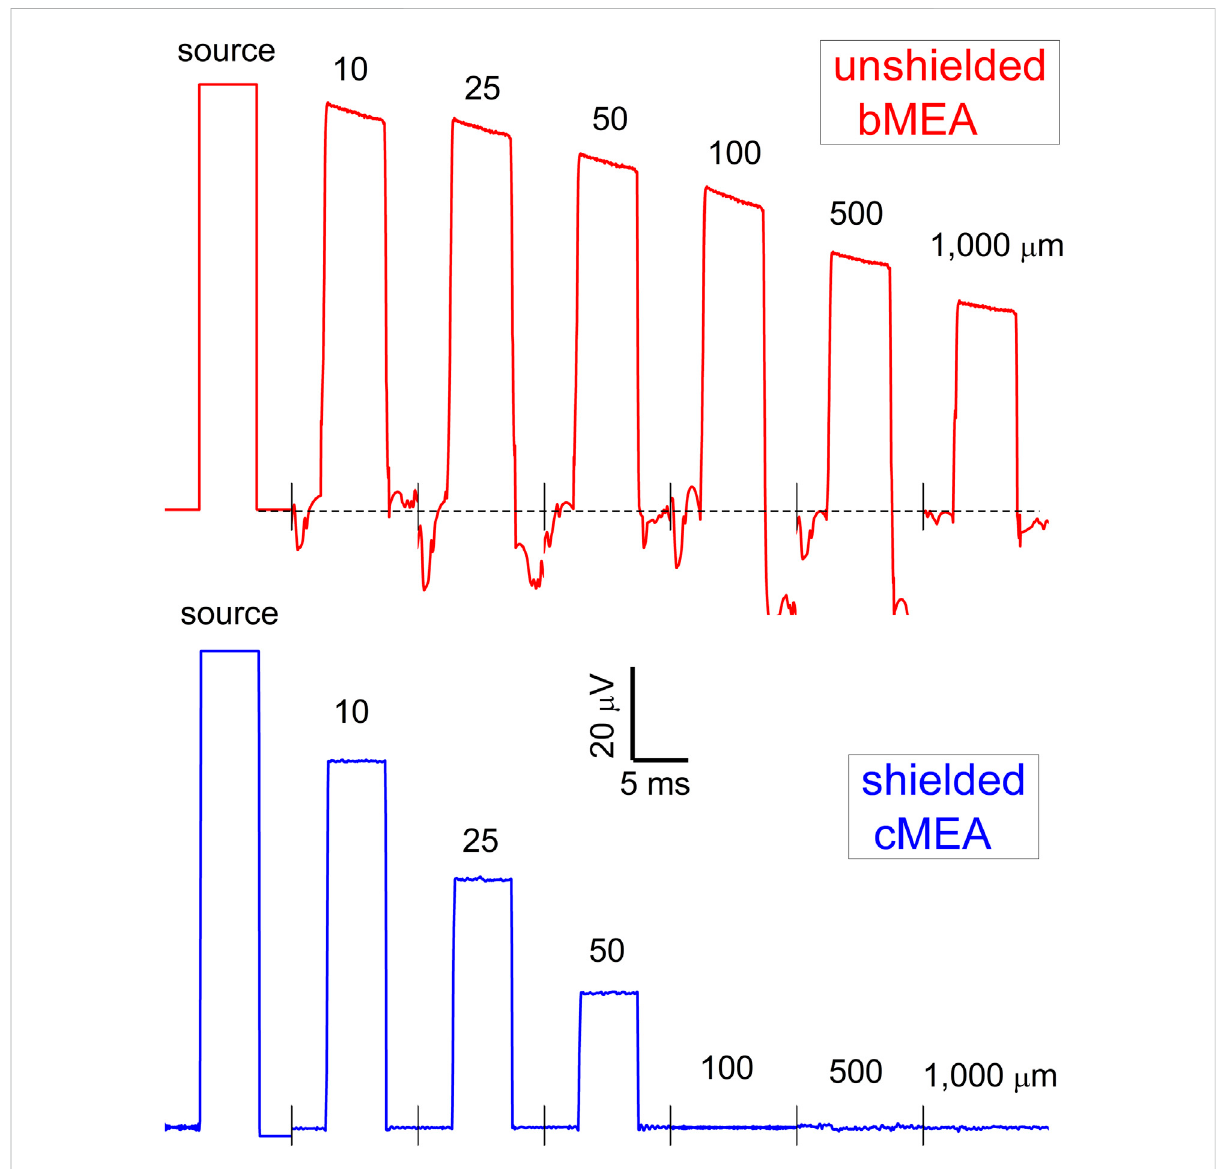
FIGURE 3 RecordingwithbMEAandcMEAunderelectricalexcitation.Voltagepulseof(100 μ V,5 ms)asappliedtooneelectrodeinthearraysofFigure1- upper indicated as source, with recorded waveforms of the bMEA (upper) and cMEA (lower) at distances from source as